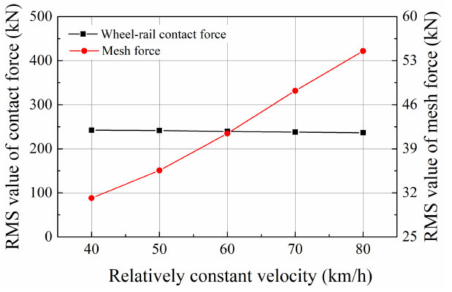
Figure 13. Variations in RMS value of dynamic excitations versus the running speed.